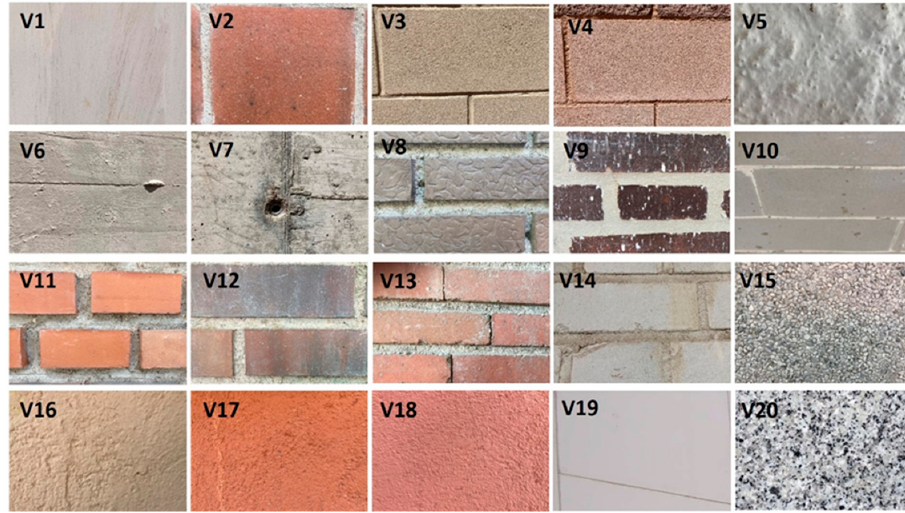
Figure 3. Vertical surface finishes.